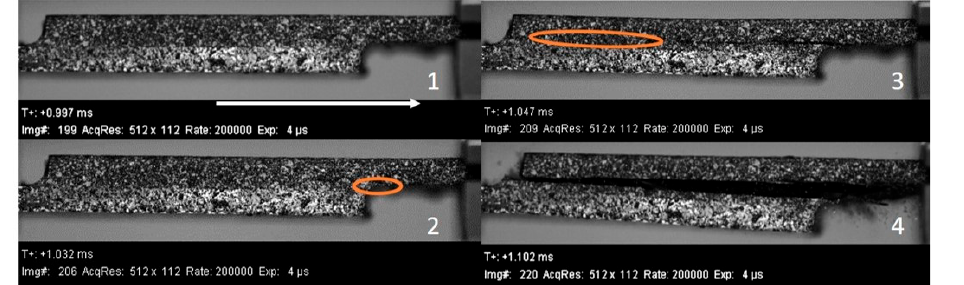
Figure 11. Failure sequence of the multi-material bonded joint BT-B05. (Supplementary Material Video S2).